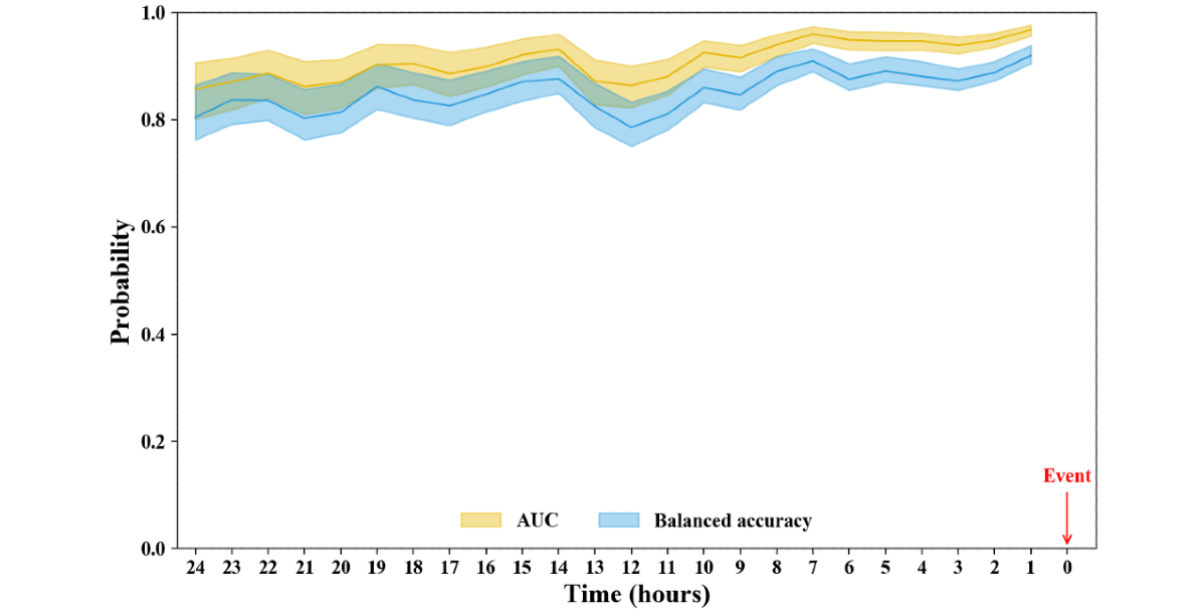
Figure 5. Time point performance in class prediction. The best model was selected based on Table 3, and the predictive performance was evaluated at each prediction time point from event occurrence. The lines and shaded 95% CIs show the trends for the predictive performance. AUC: area under the